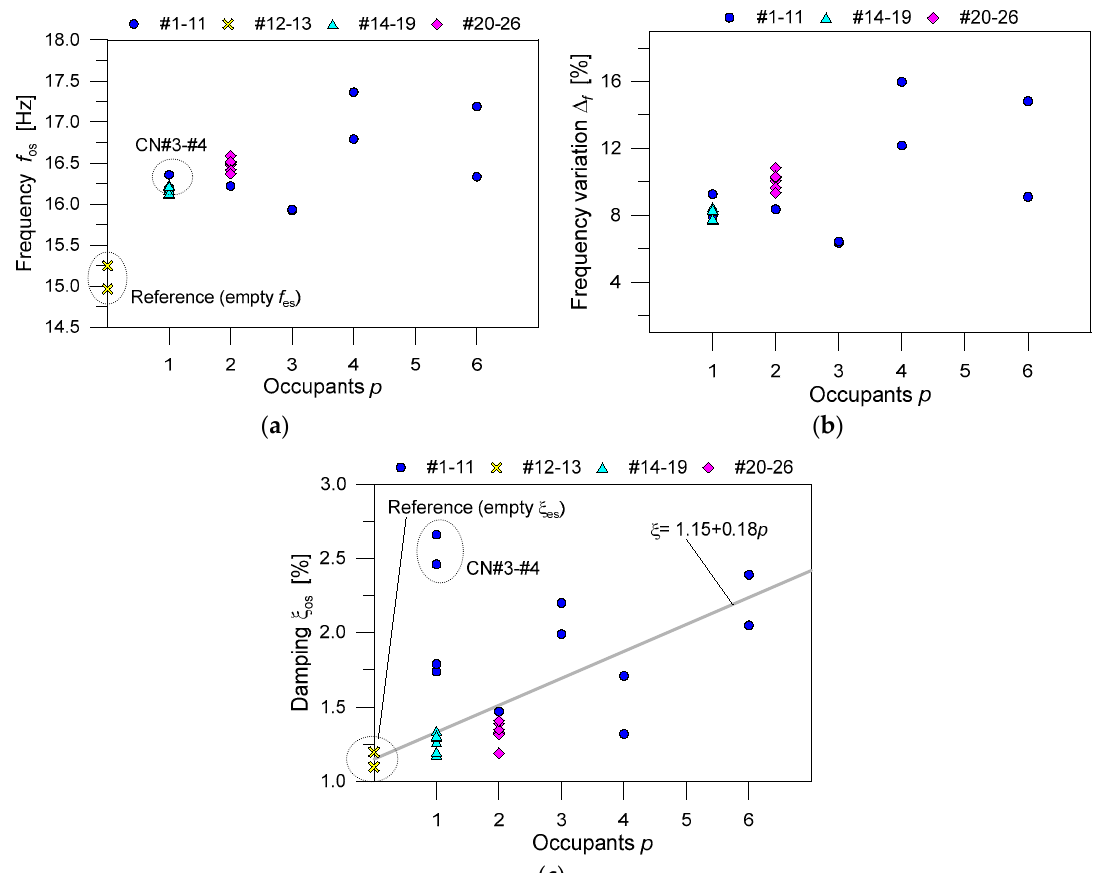
Figure 9. Variation of ( a ) frequency, ( b ) frequency scatter and ( c ) damping for the occupied system (average values).